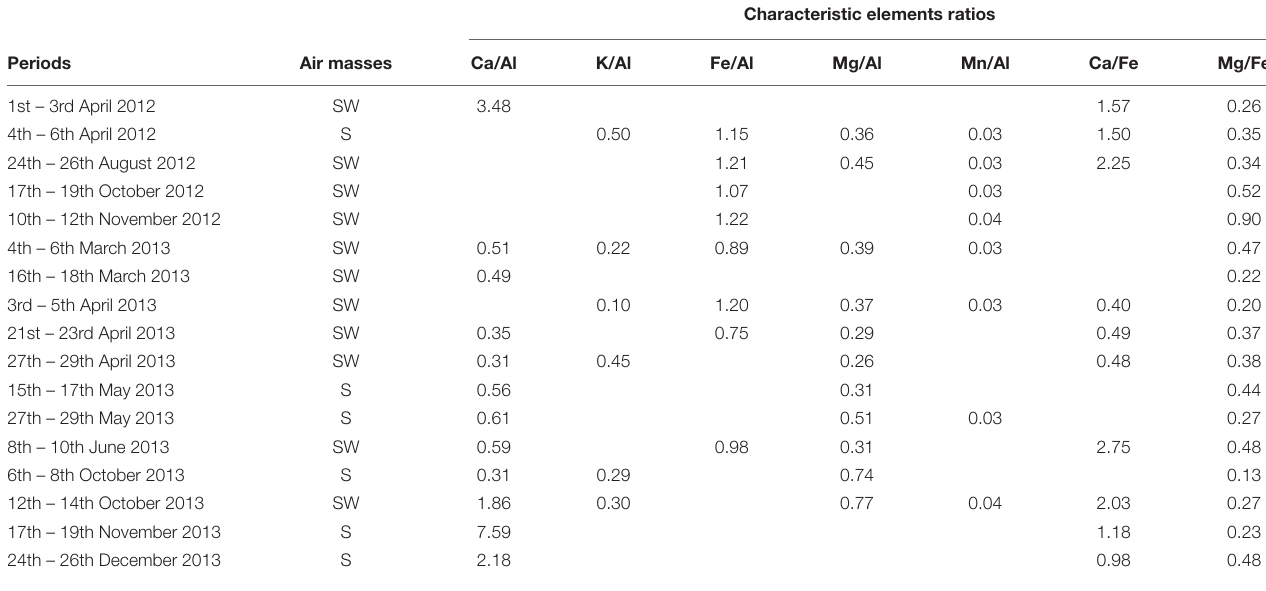
FIGURE 3 | A composite geopotential height (m) and wind flow (m/s) map (A,B) , and meridional wind component (C,D) for days of 17 and 18 events analyzed from March 2012 to December 2013 for trajectories represented in Figure 2A (left) and Figure 2B (right), respectively. TABLE 3 | Elements ratio in suburban atmospheric aerosols of central Balkans’ corresponding with their ratios in surface crustal material of Northern Africa (NA) for air masses coming from Northern Africa. Characteristic elements